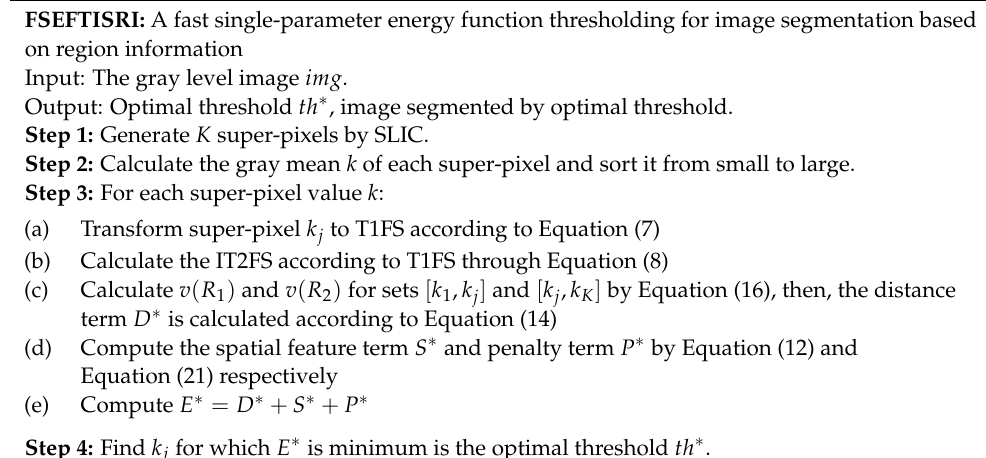
Algorithm 1. The proposed FSEFTISRI